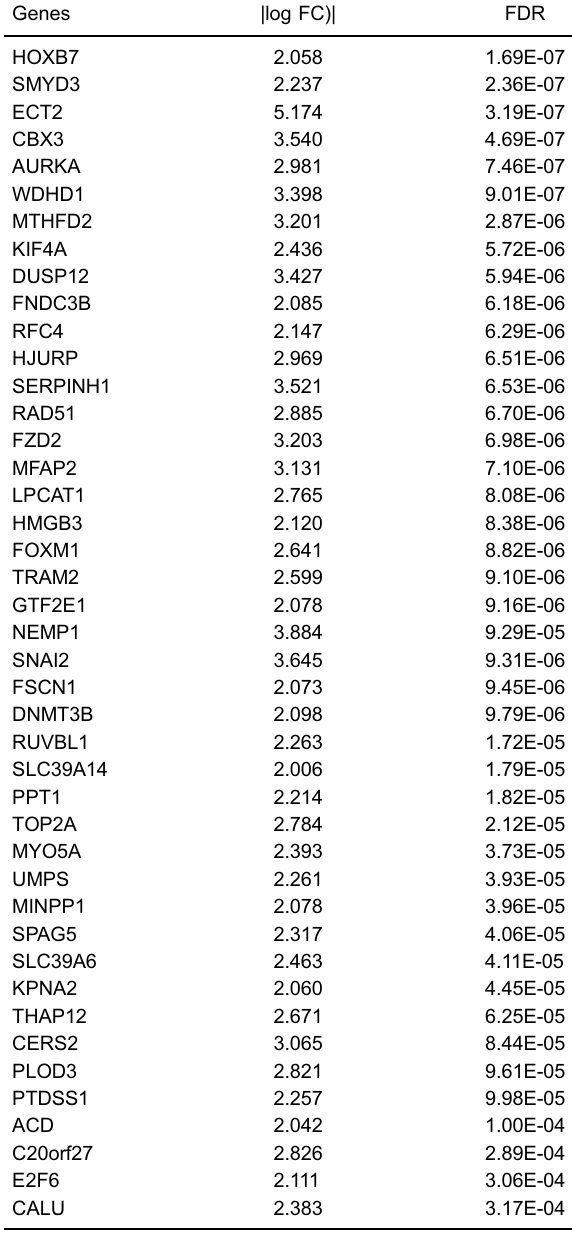
Table 1. List of differentially expressed genes